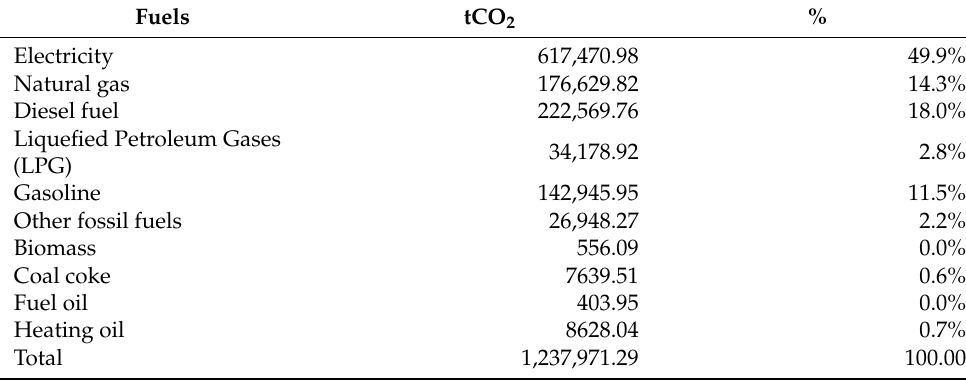
Table 7. CO 2 Emissions by fuels.